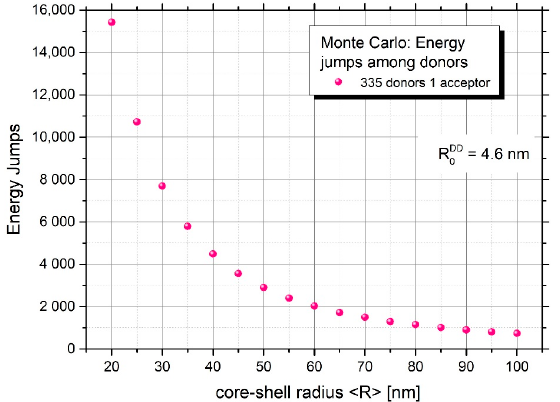
Figure 6. Mean number of excitation energy jumps in the presence of energy migration for nanoparticles of different mean radius.